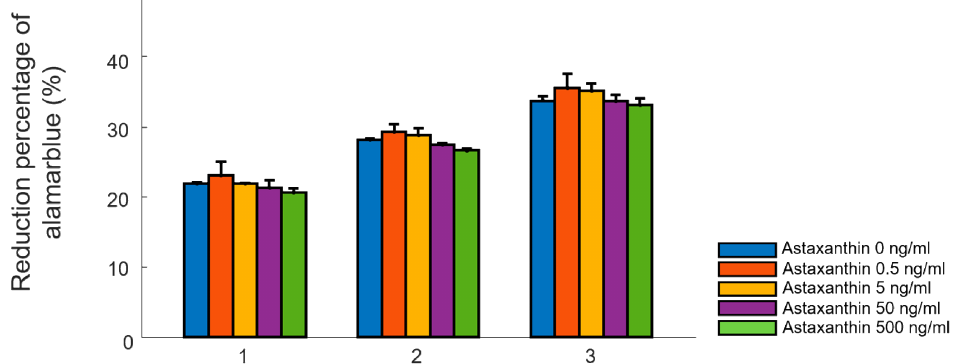
Figure 1. Proliferation test on adipose-derived mesenchymal stem cells in vitro. Cellular proliferation of adipose-derived mesenchymal stem cells treated with astaxanthin at various concentrations (0, 0.5, 5, 50, and 500 ng / ml) was assessed on day 1, 2, and 3 using alamar blue assay. Data are presented as the mean ± standard deviation (n = 3).